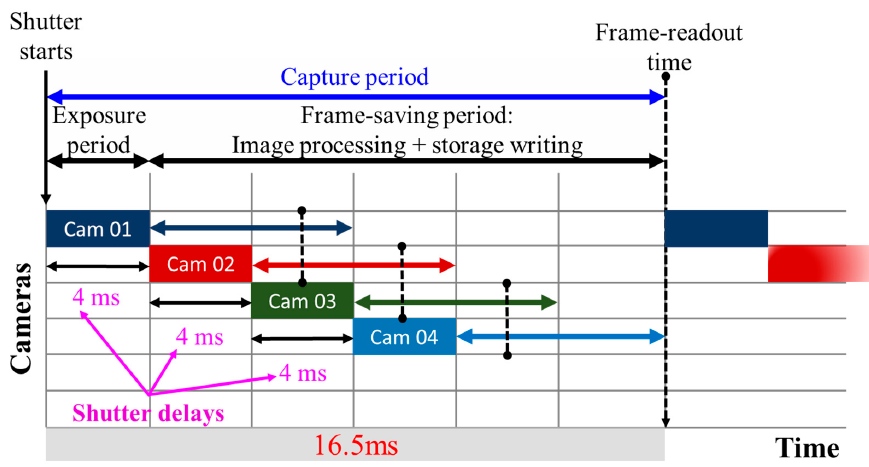
Figure 34. Timed shutter for multiple-camera frame rates.